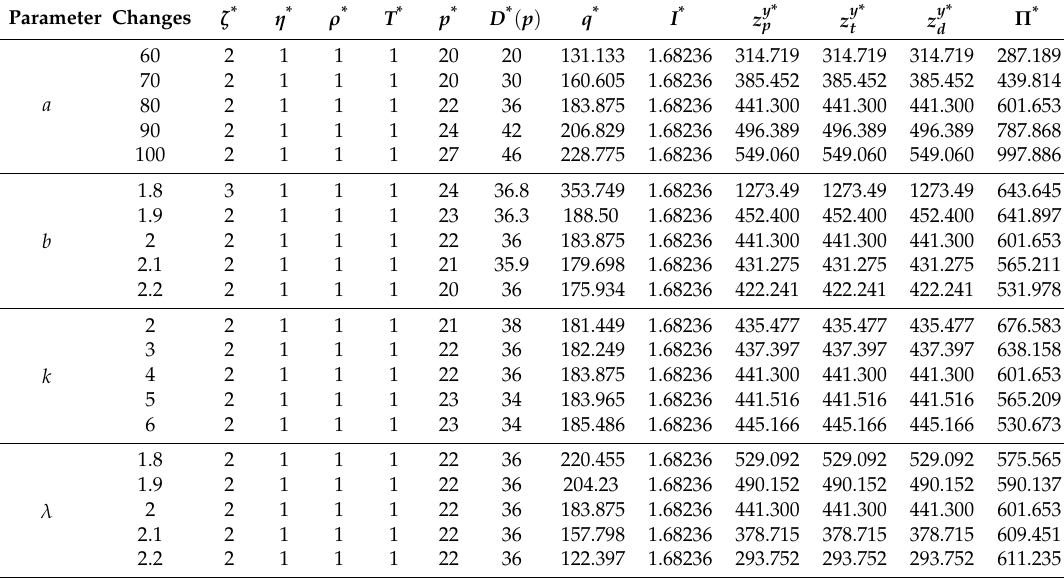
Table 5. Sensitivity analysis of key parameters of the